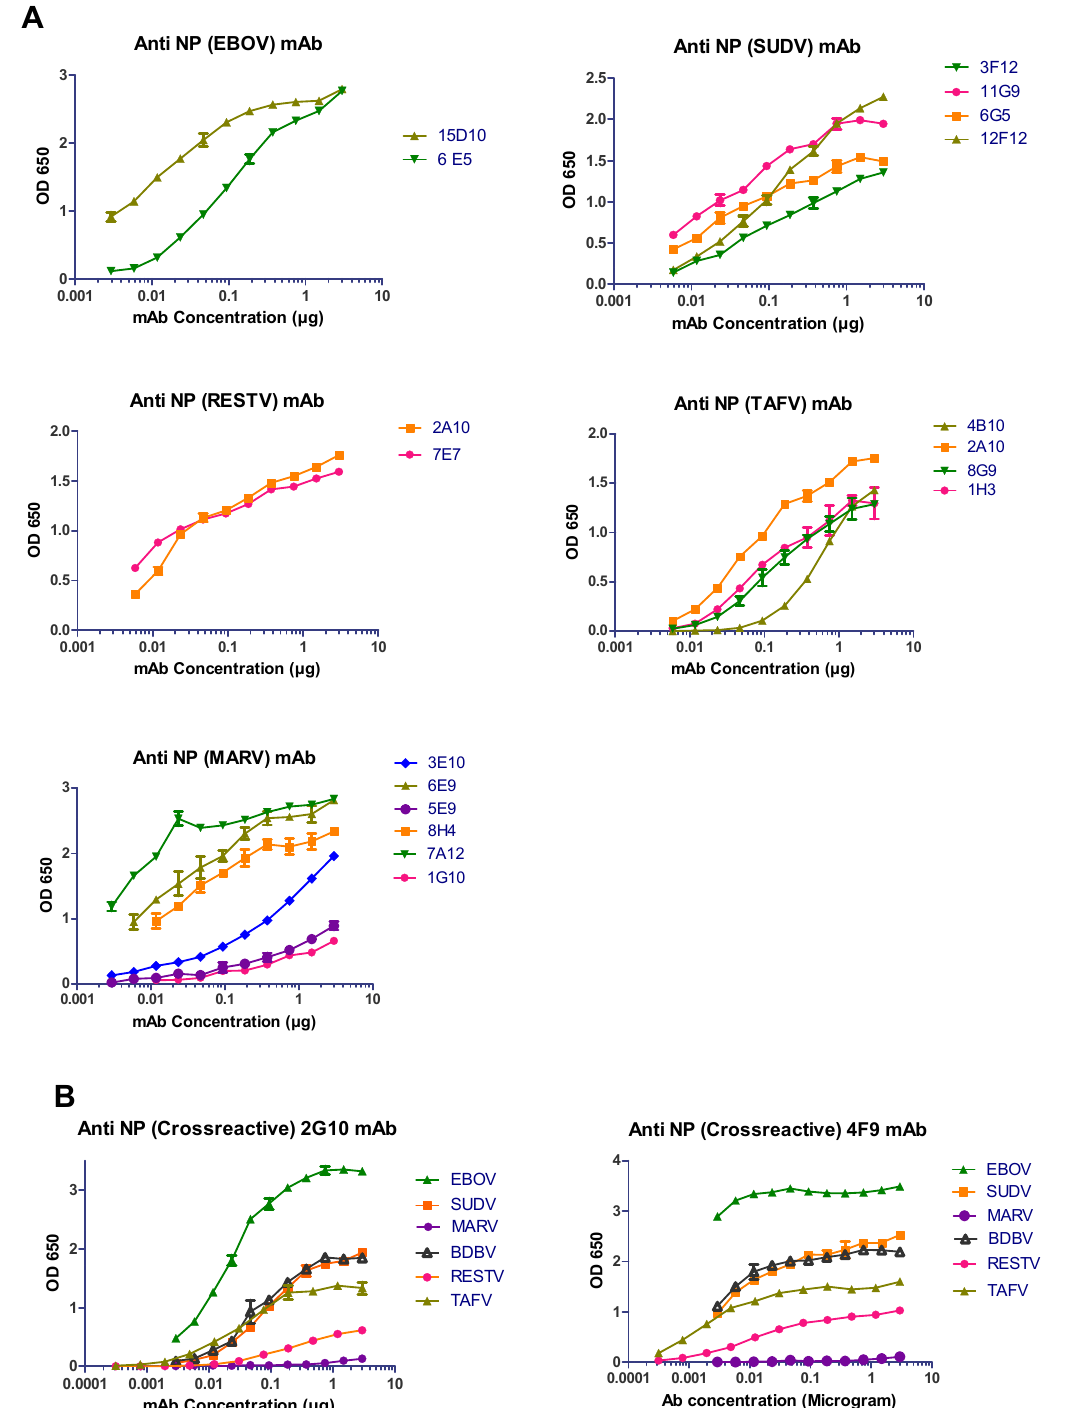
Figure 1. Anti-NP mAbs bind with wild-type filovirus NPs. ( A ) ELISA plates were coated with 40 ng of purified irradiated filoviruses EBOV, SUDV, RESTV, TAFV, and MARV. Different concentrations of purified mAbs (3 µ g–0.003 µ g per well) were added in respective plates. After blocking, the bound antibodies were detected following incubation with horseradish peroxidase (HRP)-linked secondary goat anti-mouse IgG. The optical density (OD) was determined at 650 nm. ( B ) ELISA plates coated with 40 ng of EBOV, SUDV, MARV, BDBV, RESTV, and TAFV were treated with different concentrations of purified 2G10 and 4F9 mAbs (3 µ g–0.003 µ g per well) and analyzed via binding assay.